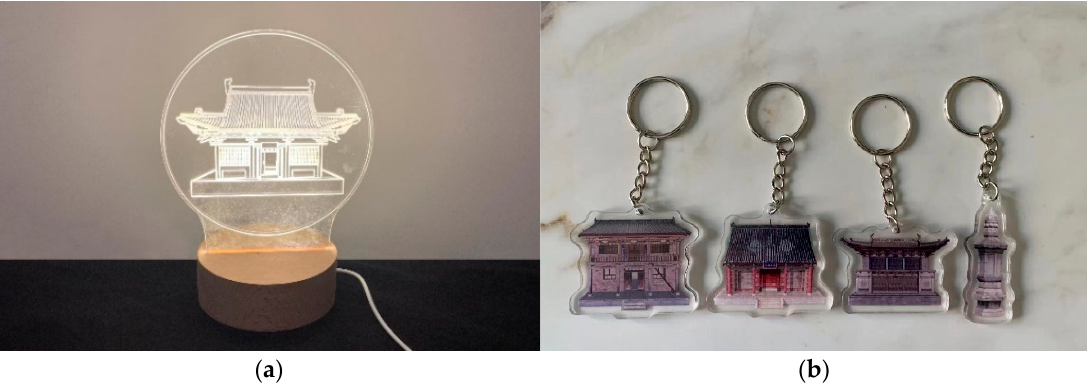
Figure 16. Cultural creativity products: ( a ) table lamp and ( b ) keychains.